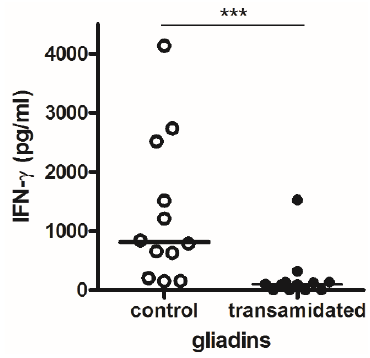
Figure 2. Antigen-specific IFN-γ expression assessed after culturing spleen cells from immunized mice for 72 h ( N = 12). Each dot represents values (pg/mL) from a single mouse calculated as the difference between the means of triplicate cultures containing antigen and triplicate cultures with medium alone. Control is the cytokine response to native gliadin. *** p < 0.001.